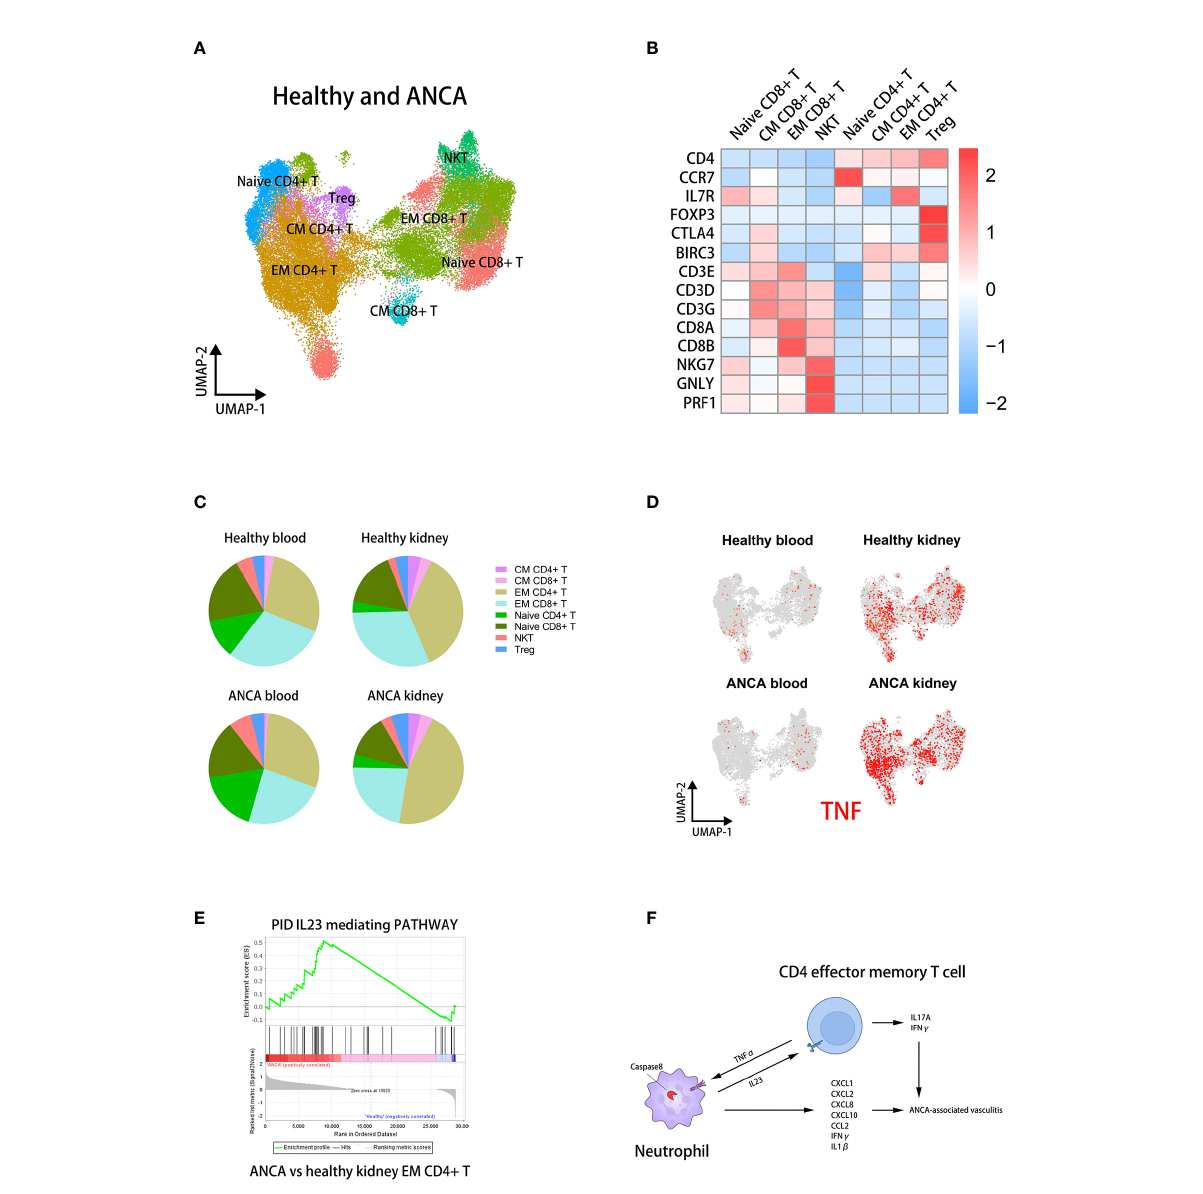
FIGURE 7 The IL23 mediating pathway in kidney EM CD4+ T cells is positively correlated with AAVs. (A) UMAP clustering of healthy and ANCA T cells in human blood and kidney sc-RNAseq datasets. (B) The heatmap showing the expression of marker genes in identi fi ed subsets. (C) The pie plots comparing the proportion of T cell subsets across groups. (D) The UMAP plot colored by TNF in T cell subsets of four groups. (E) The GSEA plots of the IL23-mediating pathway in EM CD4+ T cells for ANCA versus healthy kidney. (F) The cross-talk between neutrophils and CD4+ effector memory T cells contributing to the development of ANCA-associated